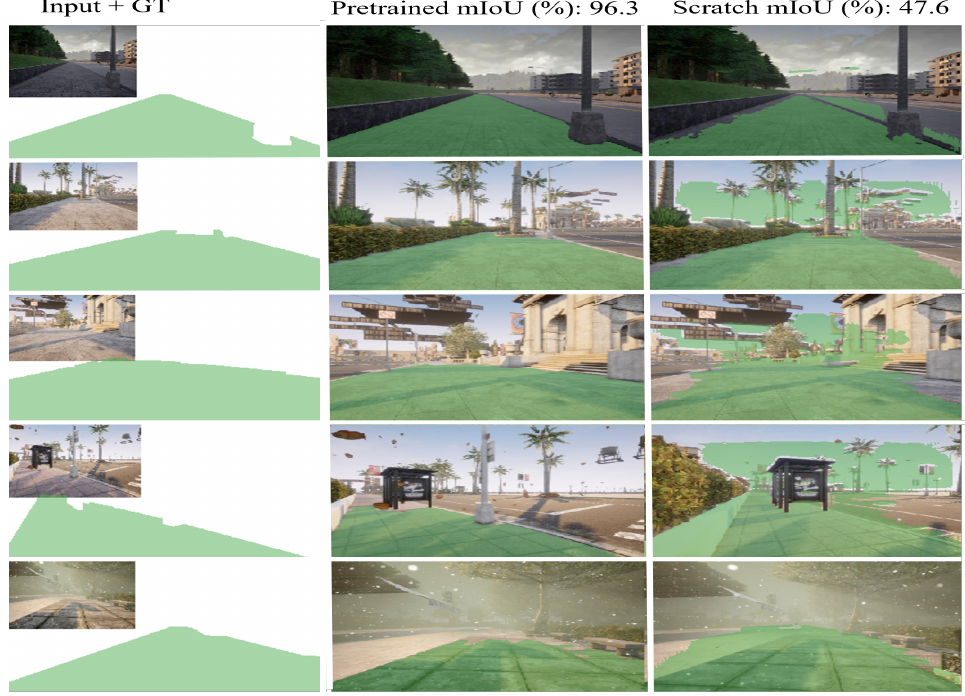
Figure 7. Binary semantic segmentation results from synthetic data in different simulation environ- ment scenarios. The first column presents the image input and the corresponding ground truth (GT) semantic label. The second column shows the obtained results from the model that was pretrained. The third column presents the obtained results from the model that was trained from